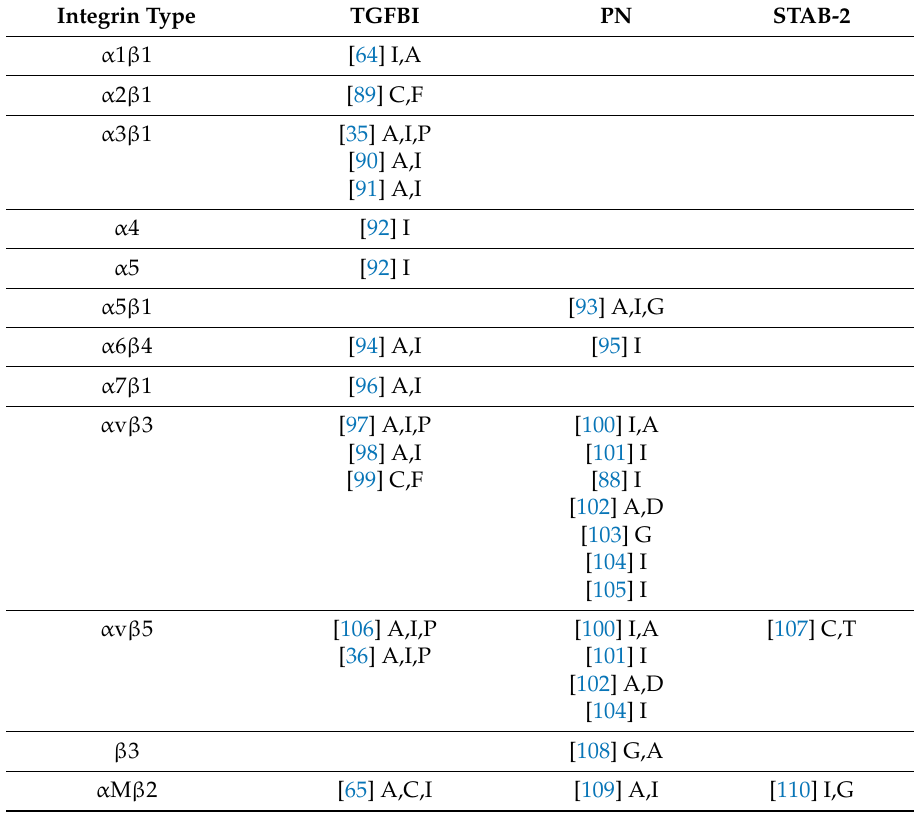
Table 1. Mammalian Fas1 proteins interact with integrin